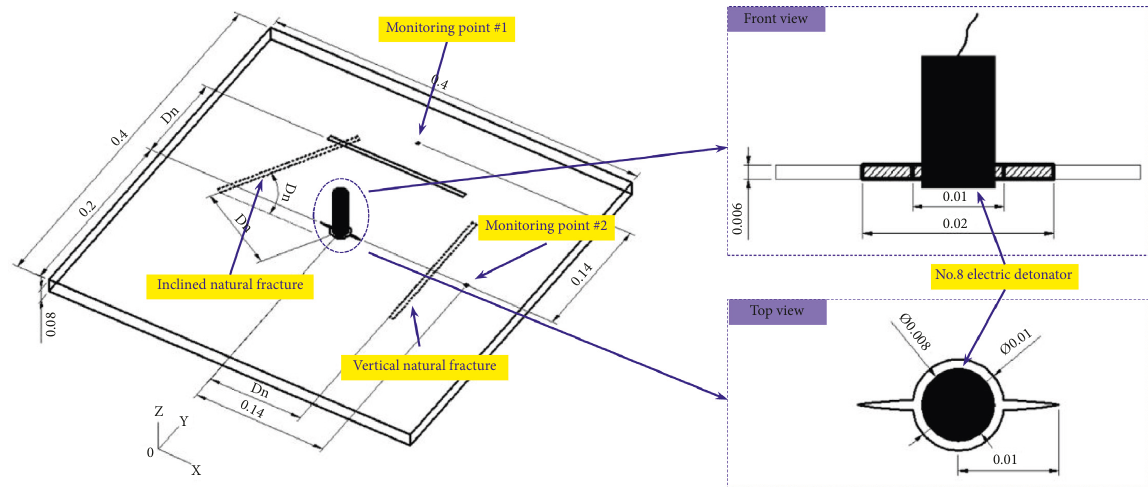
Figure 19: P-T curve for Case CN